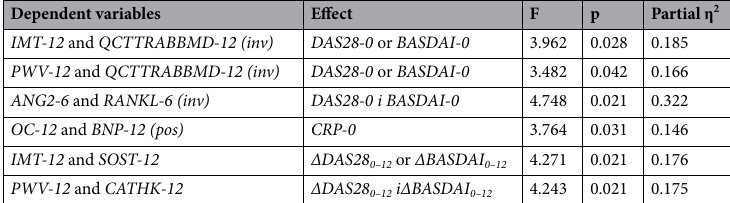
Dependent variables Effect F p Partial η 2 IMT-12 and QCTTRABBMD-12 (inv) DAS28-0 or